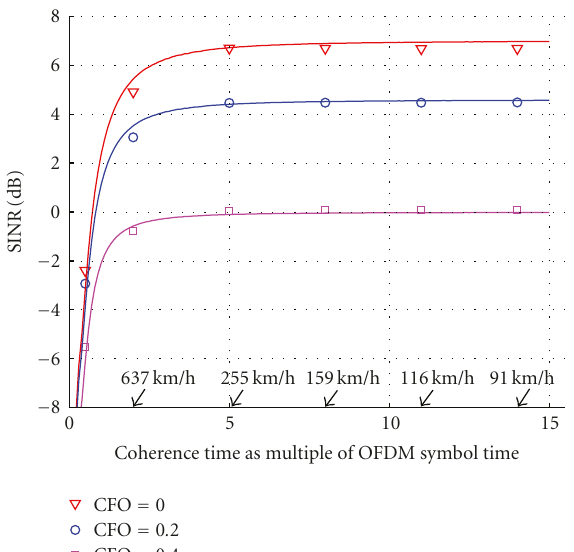
Figure 5: SINR as a function of carrier frequency o ff set for SNR levels Γ = { 7,12,18 } dB. Channel coherence time is 5 OFDM symbols. Solid curves are evaluations of (23) and markers represent simulation results. System parameters are as in Figure